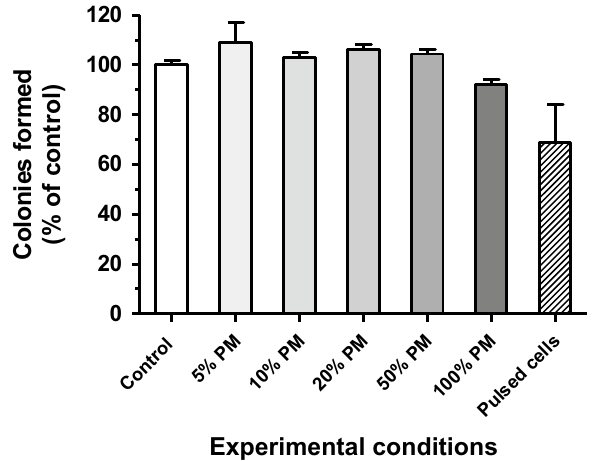
Figure 6. Long term viability of non-infected L929 cells treated with increasing fractions of pulsed medium or direct LV pulse application. Culture medium was subjected to LV pulses in the absence of cells. Then, L929 cells (5 × 10 6 cells/ml) were incubated for 40 min in a mix of crude and pulsed medium with increasing proportions of the latter, through six experimental conditions (0% to 100% PM). They were then diluted in complete DMEM medium and plated into duplicated 4 cm-wells (technical replicates). In one additional experimental condition, cells were directly subjected to LV pulses before the colony formation assay (rightmost column). Colonies were counted in each well after 5 days of culture and counts were expressed in percentages of the control condition (0% PM). PM pulsed medium, LV low voltage. Data are presented as bar chart, with means ± range of technical